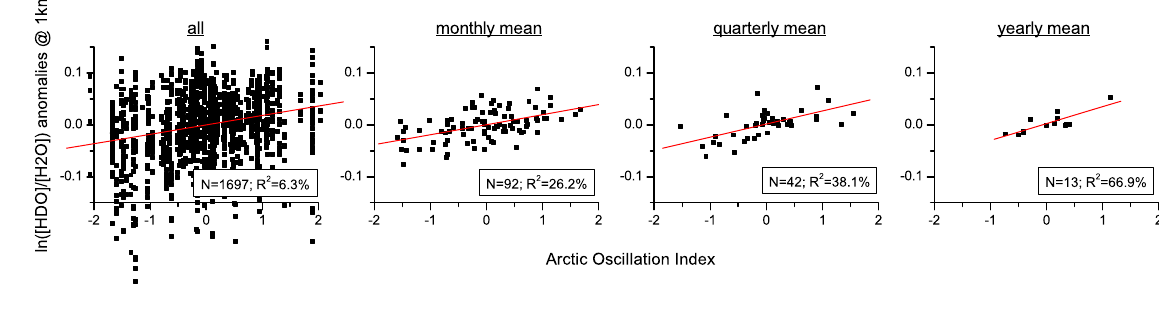
Fig. 14. Correlation plots between the AO index and δ D anomalies (expressed as ln [ HDO ] [ to the right: all individual measurements, monthly mean data, quarterly mean data, yearly mean data. The respective number of data points ( N ) and coefficients of determination ( R 2 ) are written in each panel.